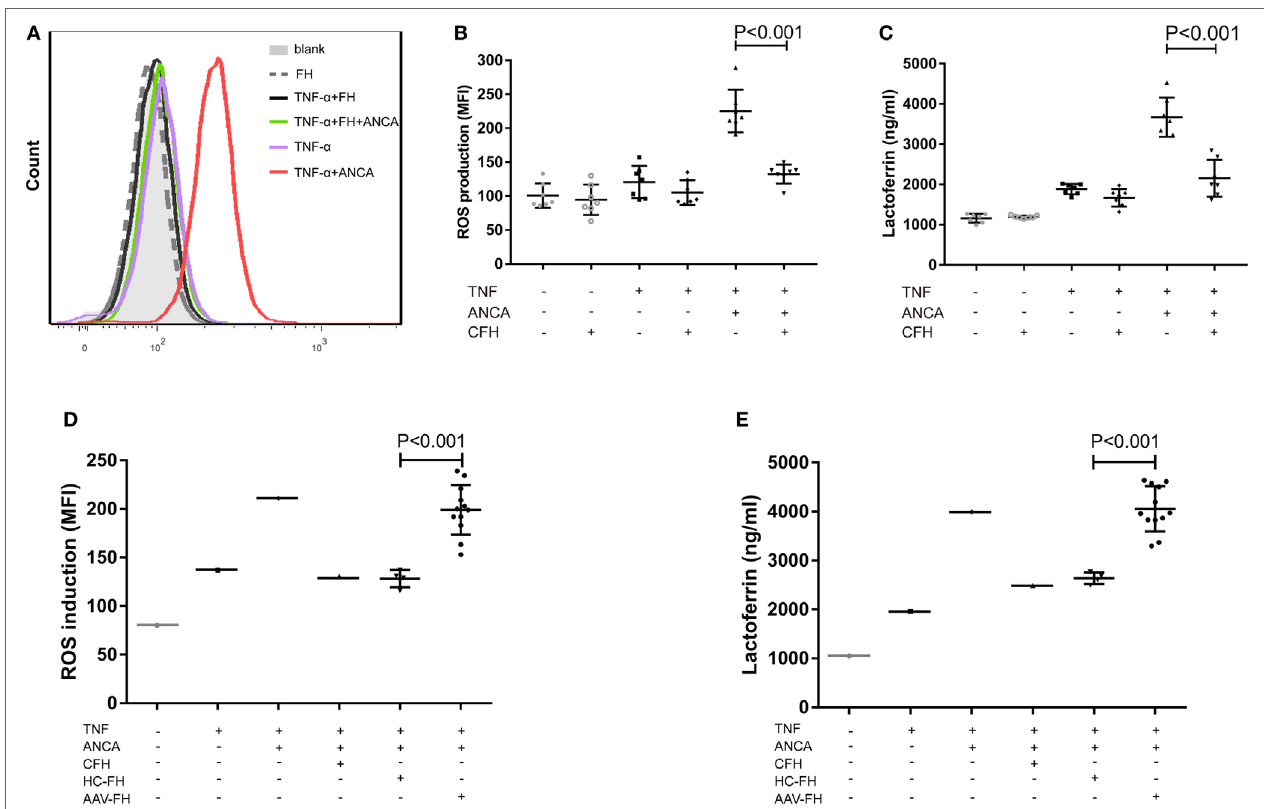
FigUre 3 | Factor H (FH) inhibits anti-neutrophil cytoplasmic autoantibody (ANCA)-induced respiratory burst and degranulation of neutrophils. (a,B) Neutrophils were primed with TNF- α followed by activation with myeloperoxidase-ANCA positive IgGs or proteinase 3-ANCA positive IgGs. Pre-incubation of neutrophils with FH resulted in marked reduction of generation of reactive oxygen species (ROS). (a) Shown is a representative histogram out of seven independent experiments. (B) The bars and error bars represent mean ± SD of ROS production in seven independent experiments using ANCA-IgGs derived from different patients with ANCA-associated vasculitis (AAV). (c) Neutrophils pre-incubated with FH showed less degranulation of lactoferrin. The values represent mean ± SD derived from seven independent experiments. (D,e) FH from patients with active AAV exhibited deficient ability in inhibiting respiratory burst and degranulation of neutrophils activated by ANCA, as compared with FH from healthy controls. Shown is mean ± SD of ROS and lactoferrin production by neutrophils pre-incubated with FH from different patients or controls, respectively. Experiments were independently repeated three times.